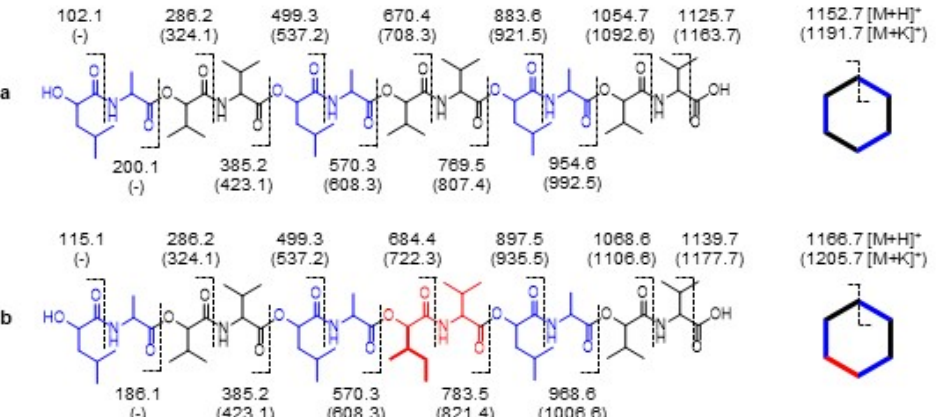
Figure 4. MS n sequences of the selected pseudomolecular ions for the structure elucidation of ( a ) cereulide ( 1 ) and ( b ) isocereulide A ( 2 ) (black: L - O -Val- L -Val, blue: D - O -Leu- D -Ala, red: L - O -Ile- L - Val).